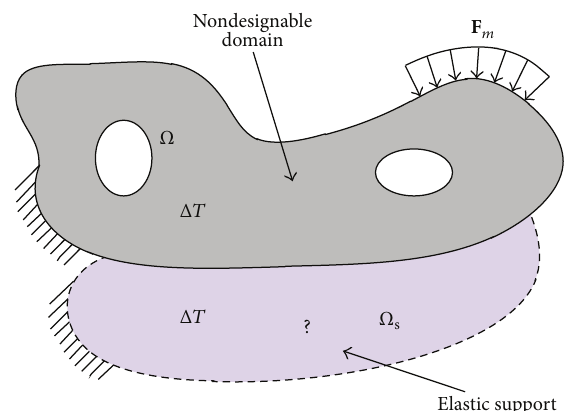
Figure 1: Topology optimization of thermoelastic structure with elastic support.